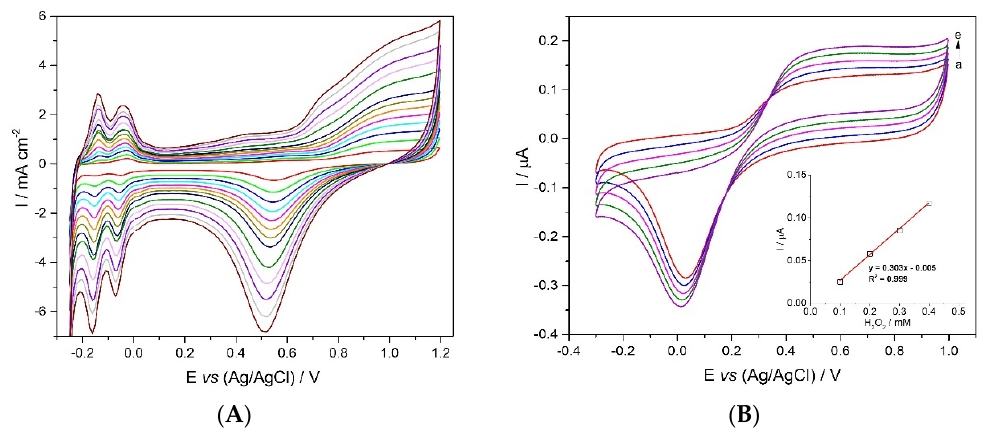
Figure 1. Electrochemical behavior of the CMF/Pt in acidic and neutral electrolyte media. ( A ) Successive cyclic voltammograms (25th scan) at increasing scan rates (50–1000 mV s − 1 ) obtained in deoxygenated H 2 SO 4 (0.5 M); ( B ) Cyclic voltammograms between − 0.3 and + 1.0 V vs. Ag/AgCl obtained with a CFM/Pt in deoxygenated phosphate-buffered solution (0.05 M, pH 7.4) at a scan rate of 0.05 V s − 1 in the absence (a) and presence of increasing concentrations of H 2 O 2 (b–e); 0.1–0.4 mM); Inset: plot of anodic ( I pa ) peak currents (at +0.7 V) as a function of H 2 O 2 concentration, showing the respective linear regression equation.